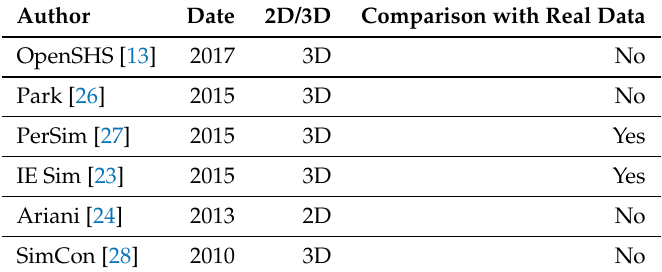
Table 1. Table summarizing notable works which have produced interactive simulation tools for Smart environments. This highlights the lack of comparison with real world